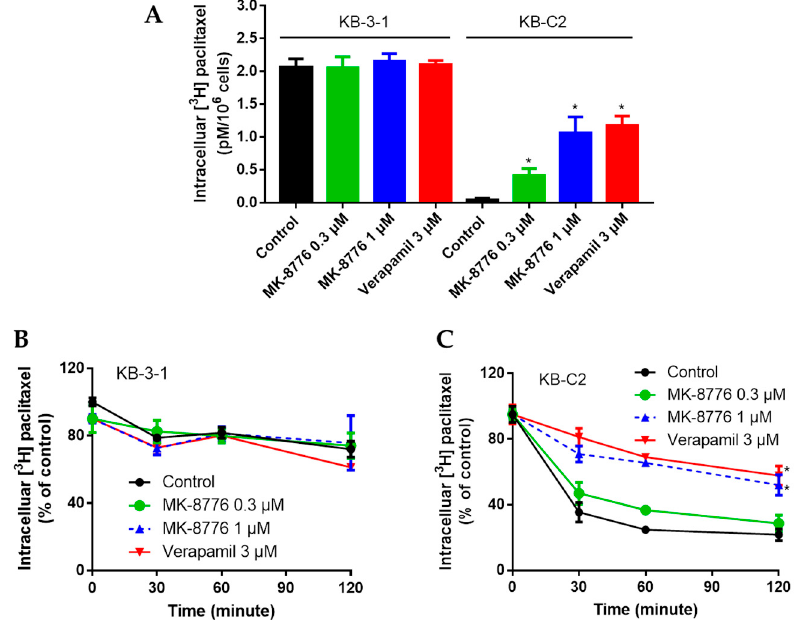
Figure 2. Effects of MK-8776 on the intracellular accumulation of [ 3 H]-paclitaxel in KB-C2 cells that overexpress P-gp ( A , C ) and their parent KB-3-1 cells ( A , B ). * p < 0.05 vs.